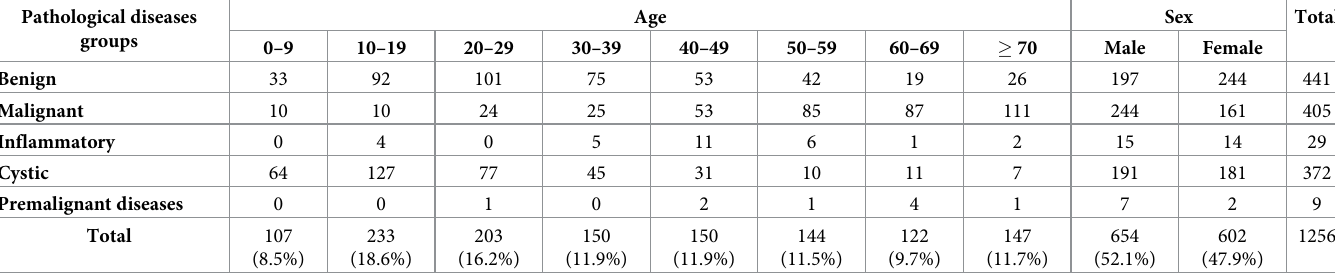
Table 5. Pathological disease groups distribution by age (years) and